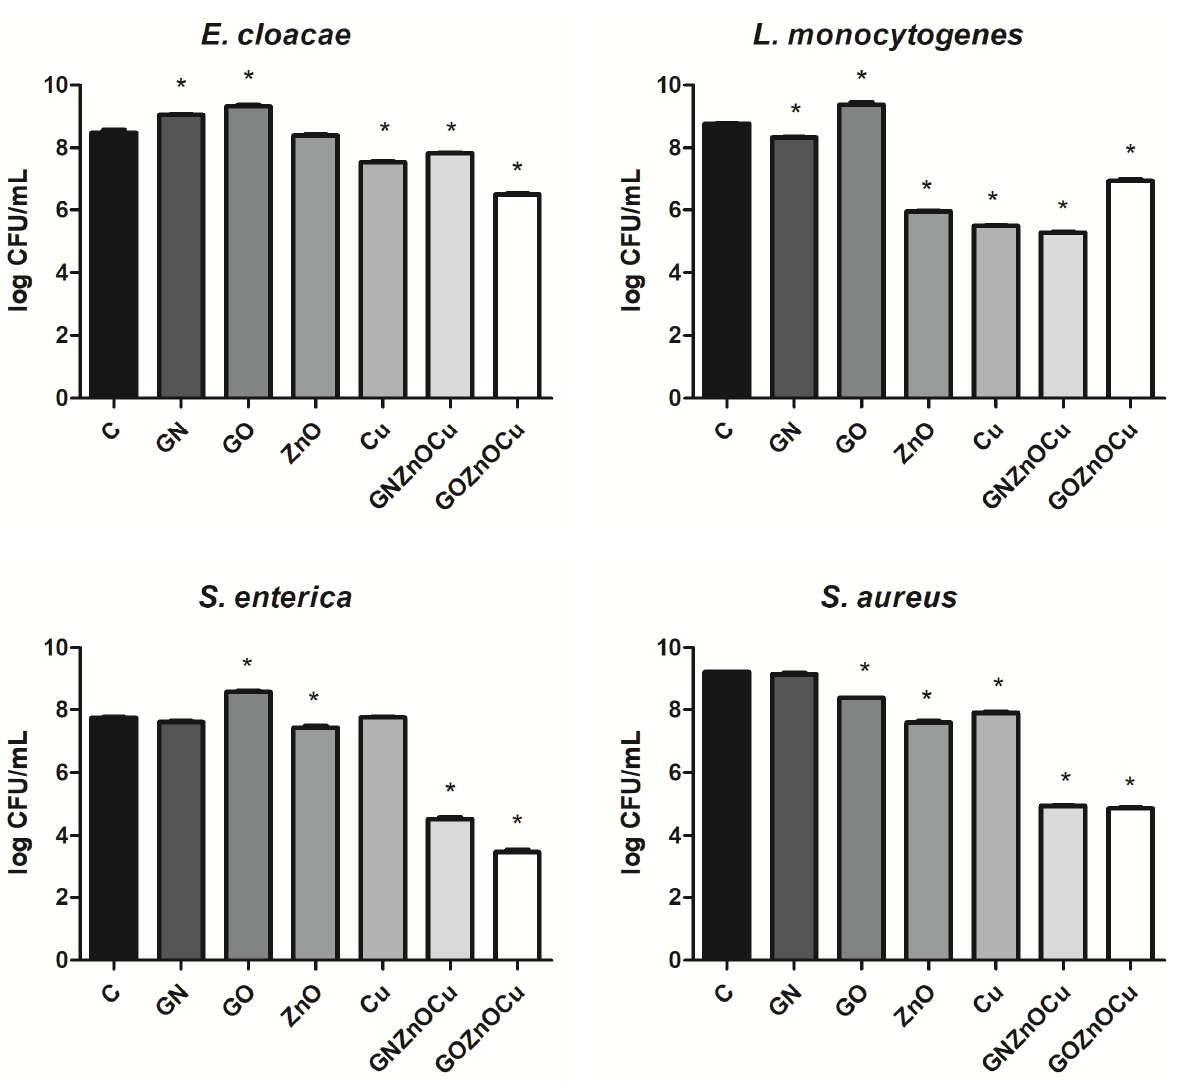
Figure 5. Mean CFU/mL (log) for bacteria after treatment with nanoparticles. C is the control sample, and the results are mean values ± standard deviation. “*” symbols indicate statistically significant differences in comparison to the control.